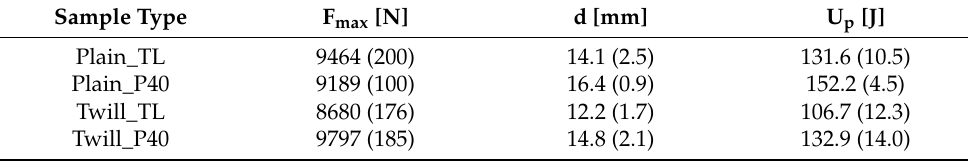
Table 2. Impact parameters at penetration. Standard deviations are reported in brackets. Sample